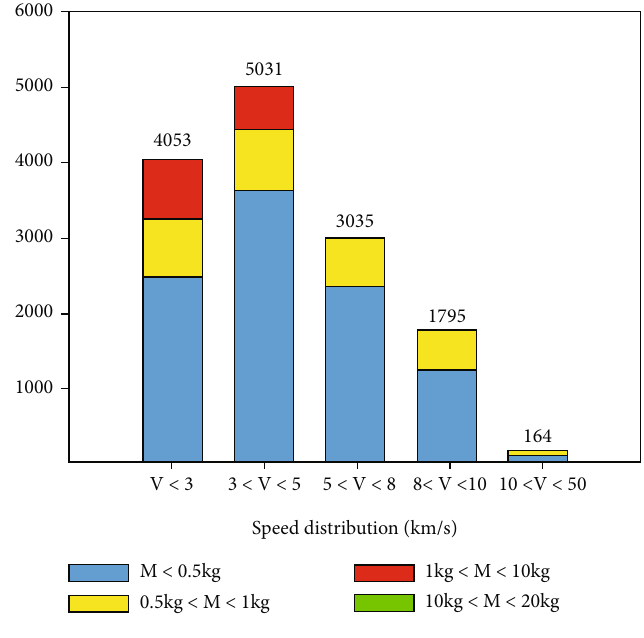
Figure 18: Debris velocity distribution.